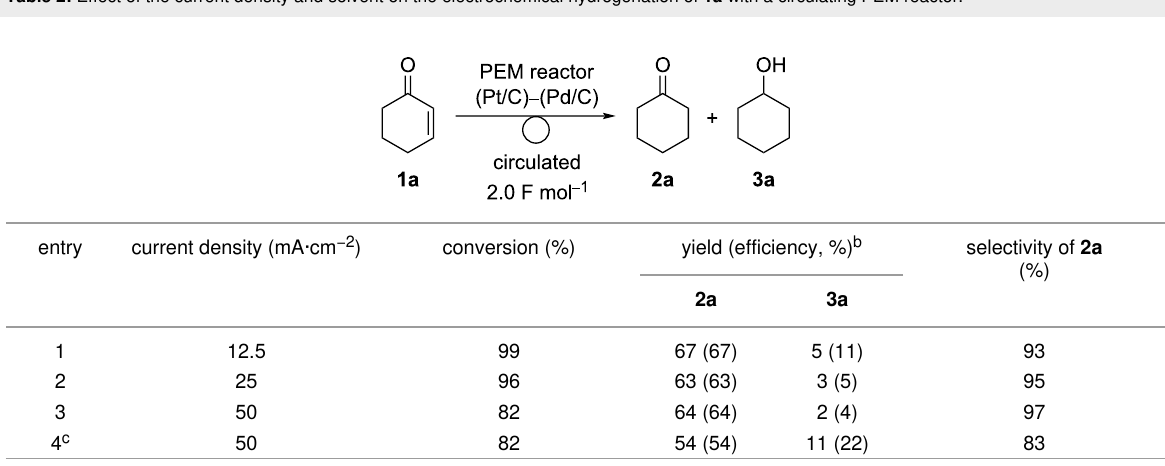
Table 2: Effect of the current density and solvent on the electrochemical hydrogenation of 1a with a circulating PEM reactor. a